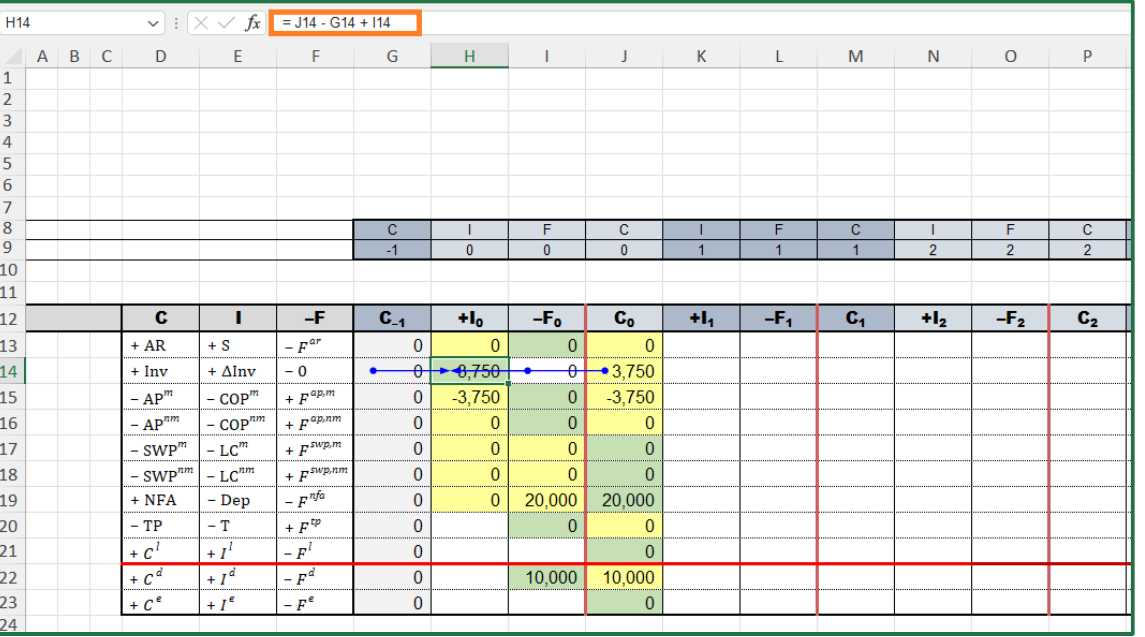
Figure 15. Cell I13 contains the law of motion for the cash receipts from customers (“SplitScreen- Strip” sheet). (The cells whose values are provided in “PreCalc” are in yellow and the cells whose values are calculated with the law of motion are in green.)